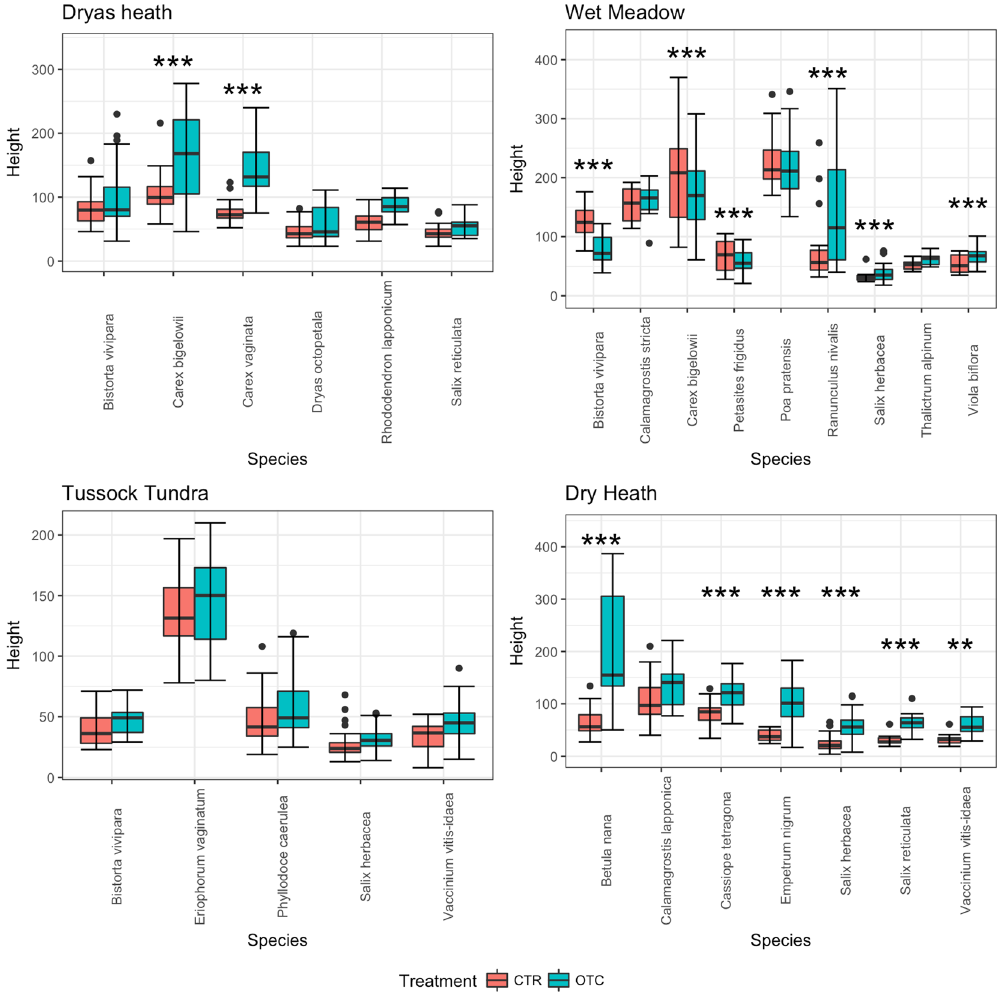
Figure 3. Height response (in mm) of different plant species to 23 years of warming (open-top chamber, OTC) compared with a control treatment